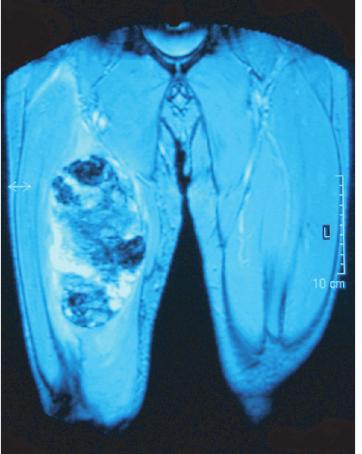
Figure 3: T2-weighted gradient-echo pulse sequence. Marked low signal is seen centrally secondary to magnetic susceptibility artefact from